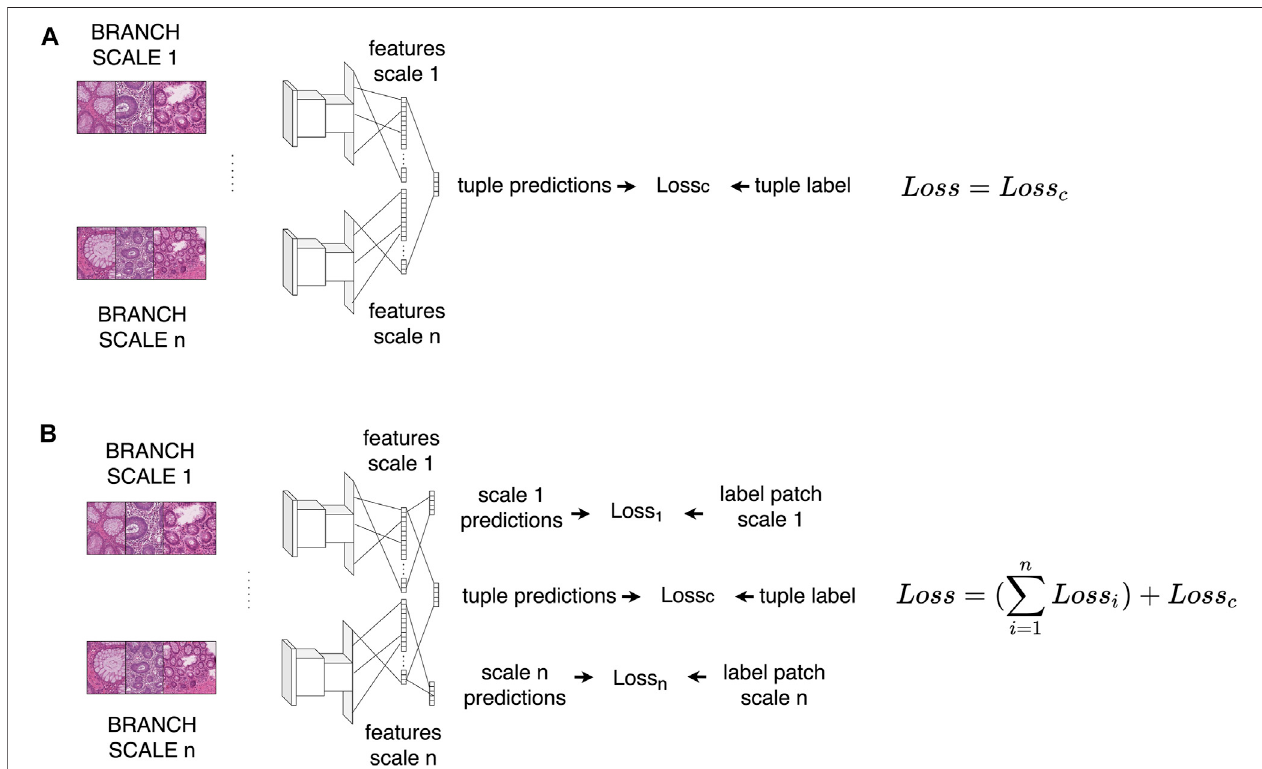
FIGURE 5 | The fi rst multi-scale CNN architecture, in which features are combined from different scale branches, optimizing only one loss function (A) and optimizing n + 1 loss function (B) .